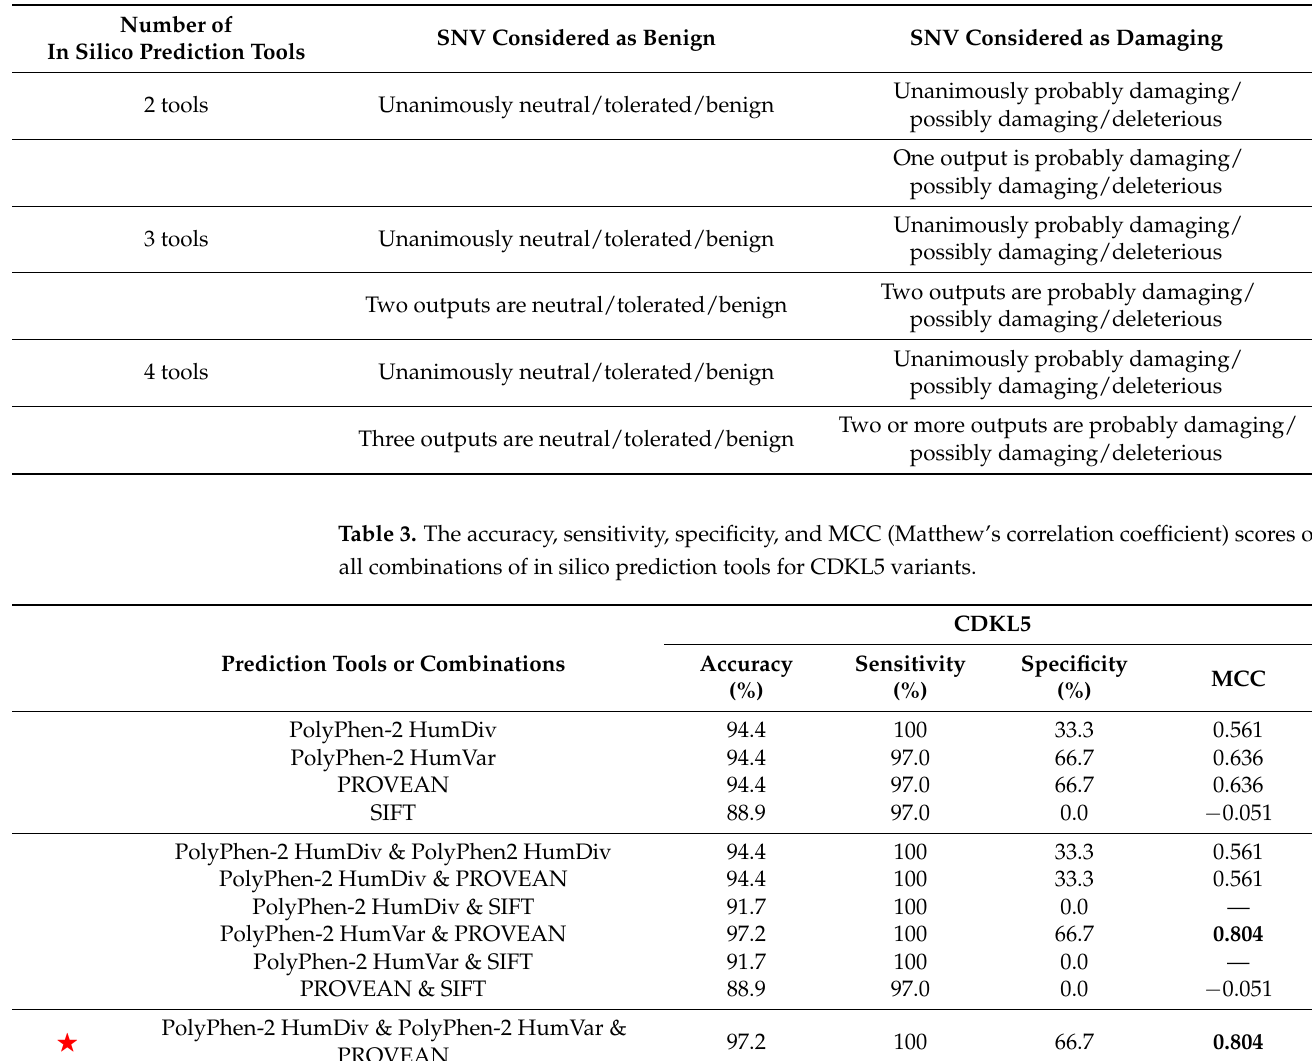
Table 2. Conditions for single nucleotide variant (SNV) data output from 2 to 3 and all in silico missense prediction tools are considered to be either benign or damaging.